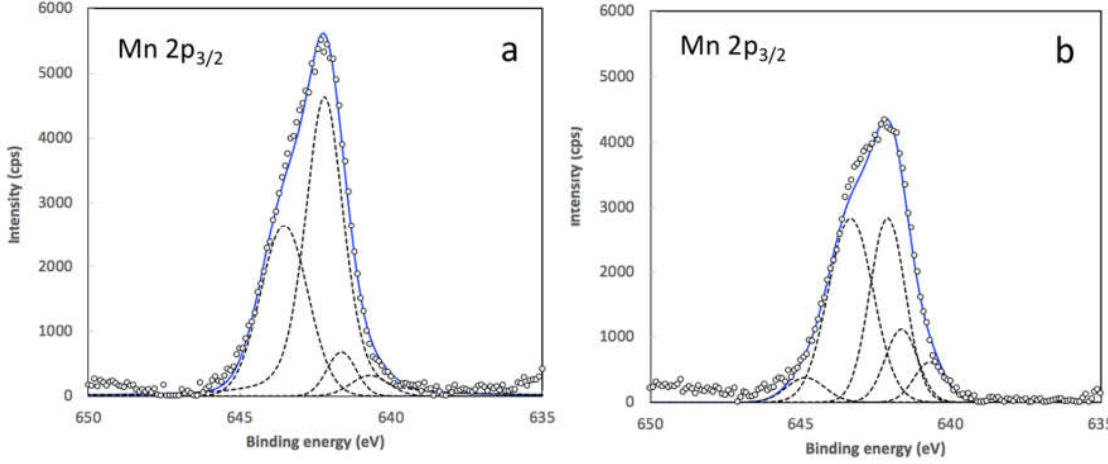
Figure 11. Manganese (Mn 2p 3/2 ) XPS spectra of ( a ) unreacted MnO 2 and ( b ) Cr(III)-treated MnO 2 . Dashed lines are the Gaussian–Lorentzian fit peaks described in Table 1 and the solid line is the sum-fit line.